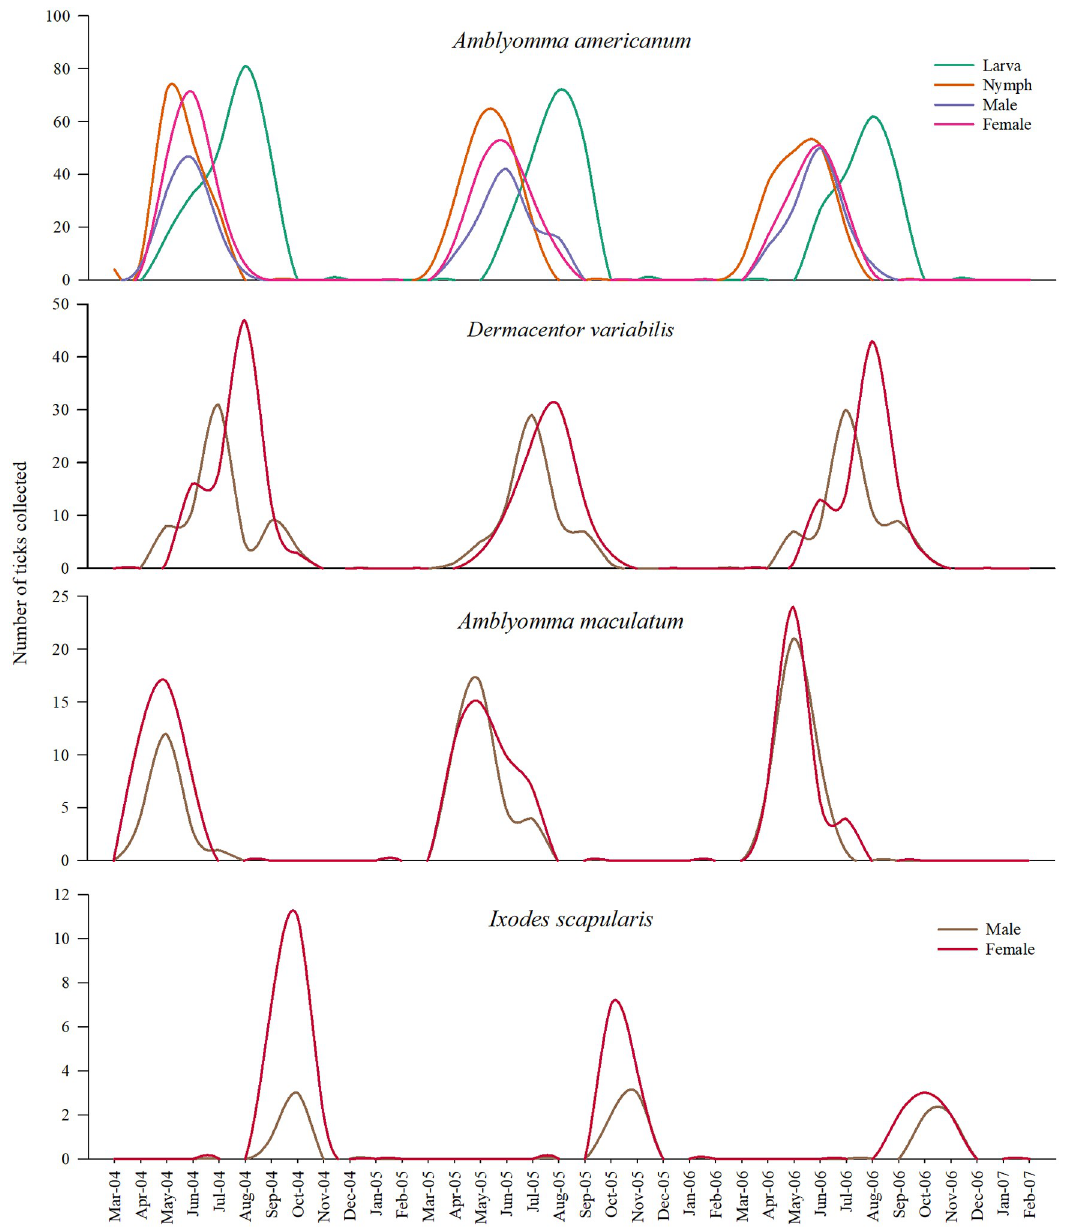
Fig 4. Tick phenology observed in predominantly woodland vegetation near Pittsburg, Kansas between years 2014–2017. Lines represent total number of individual specimens collected at monthly intervals and are not smoothed